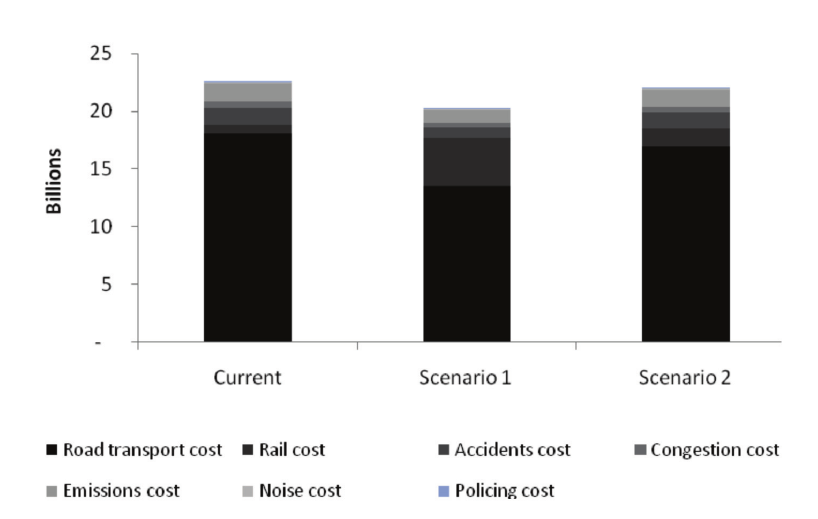
Figure 6: Comparative cost components: current vs. switching scenarios (data source: FDM, 2009, and CSCM Cost Model,